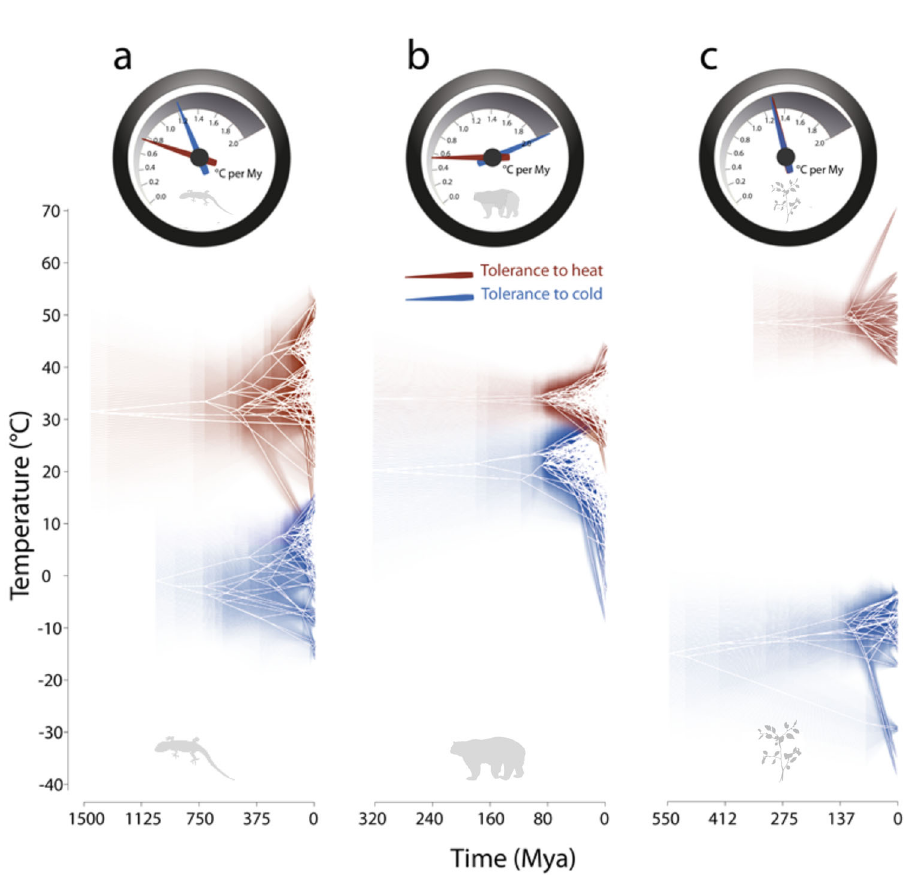
Fig. 3 Tempo and mode of evolution of thermal tolerance limits. Tempo and mode of evolution of upper (red) and lower (blue) thermal tolerance limits of a ectotherms, b endotherms and c plants (photosynthetic plants and macroalgae). The top velocimeters illustrate the rate of evolution as measured by σ ². Estimates of σ ² are computed as the average between the results for the smoothed and unsmoothed phylogenetic trees in ref. 18 . Sample sizes and details on the uncertainty around the estimates are supplied in Supplementary Tables 2 – 4 and see Supplementary Note 2. The bottom traitgrams together with the uncertainty about ancestral character states shown by increasing transparency illustrate the phenotypic change along evolutionary